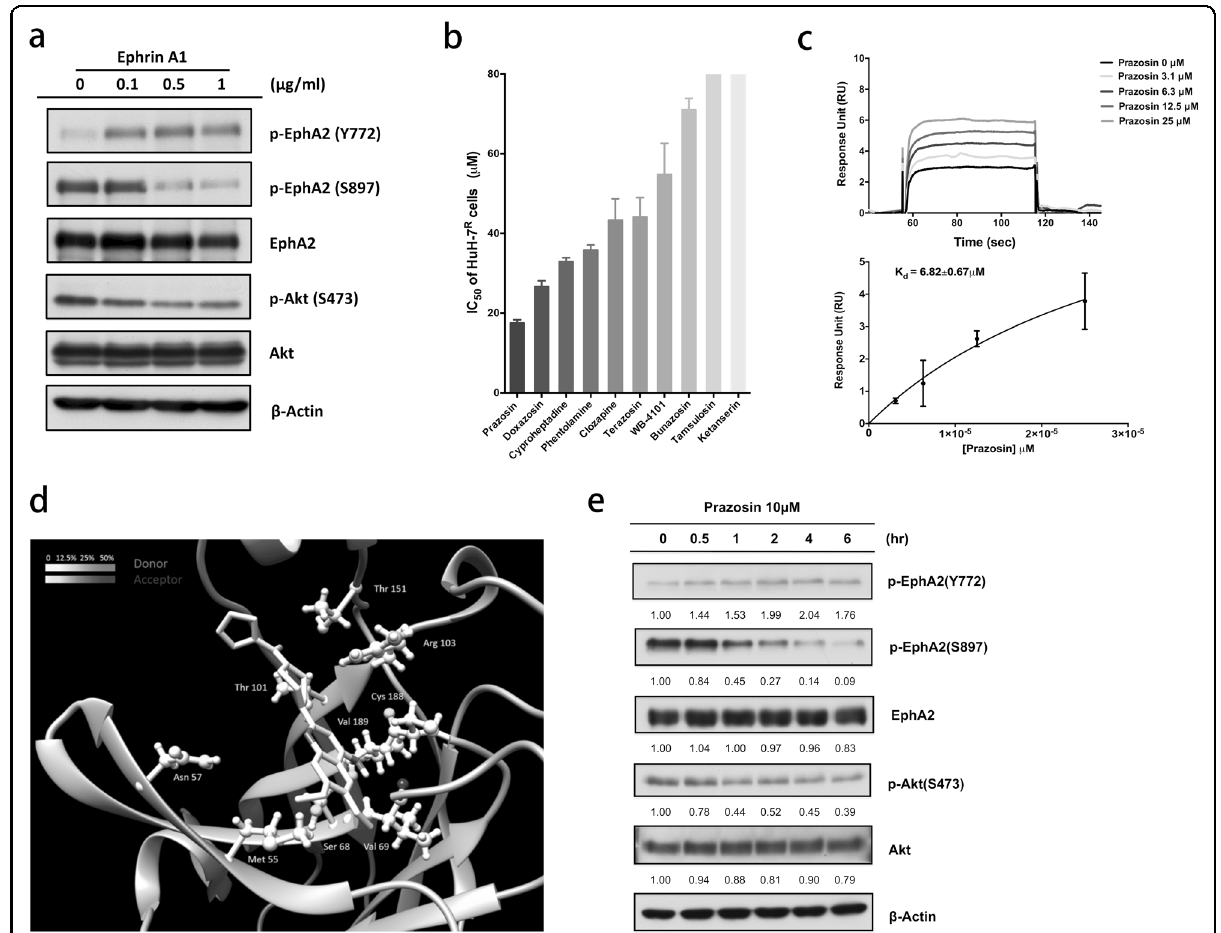
Fig. 4 Screening of small molecular agonists for EphA2-targeted inhibition. a Ligand-dependent inhibition of oncogenic activity of EphA2 and Akt phosphorylation in HuH-7 R cells. HuH-7 R cells were treated with Ephrin-A1-Fc at the indicated concentrations. Cell lysates were separated via SDS- PAGE and analyzed using western blotting with the speci fi ed antibodies. b The small-scale screening of quinazoline-based compounds was performed and the IC 50 values for HuH-7 R cells were determined with the MTT assay. c Validation of the EphA2-binding af fi nity of prazosin analyzed via the surface plasmon resonance (SPR) assay. Representative binding response and saturation curves are shown. d The molecular dynamic simulation of prazosin complexed with EphA2 was performed with the AMBER 16 software using the crystal structures of EphA2 (3CZU) and prazosin (3OWX) adopted from the RSCB Protein Databank. The molecular plot was generated using UCSF Chimera. The presented amino acids are potentially involved in hydrogen bonding interactions with prazosin, with the level of likelihood displayed in shades of gray. e Inhibitory effects of prazosin on EphA2 and Akt phosphorylation in HuH7 R cells. HuH7 R cells were treated with 10 μ M prazosin for the indicated times. The cell lysates were separated via SDS-PAGE and analyzed using western blotting with the speci fi ed antibodies. The intensity was quanti fi ed via densitometry and normalized to that of β